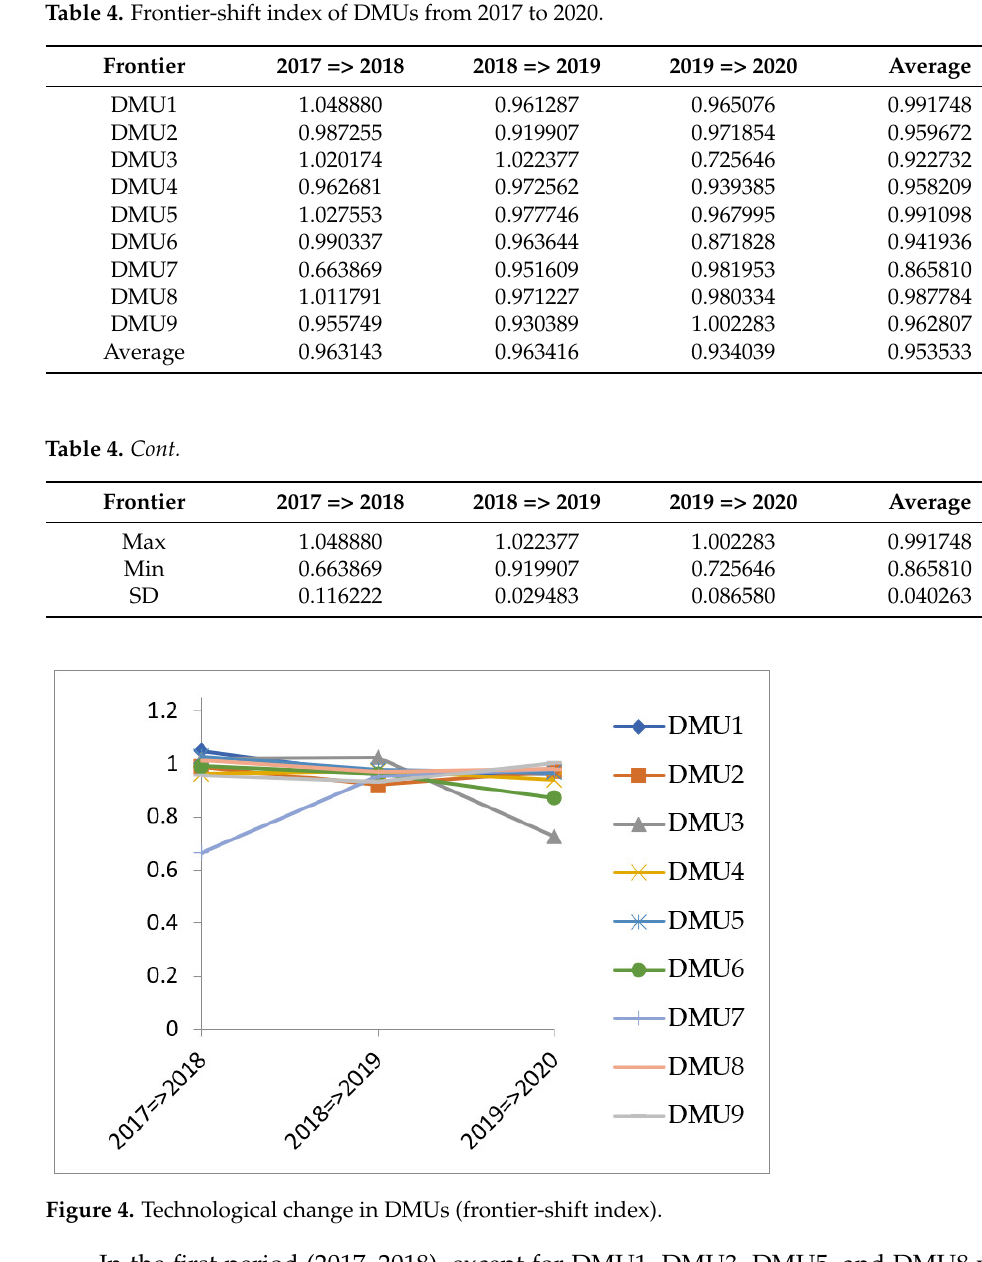
Table 4. Frontier-shift index of DMUs from 2017 to 2020.